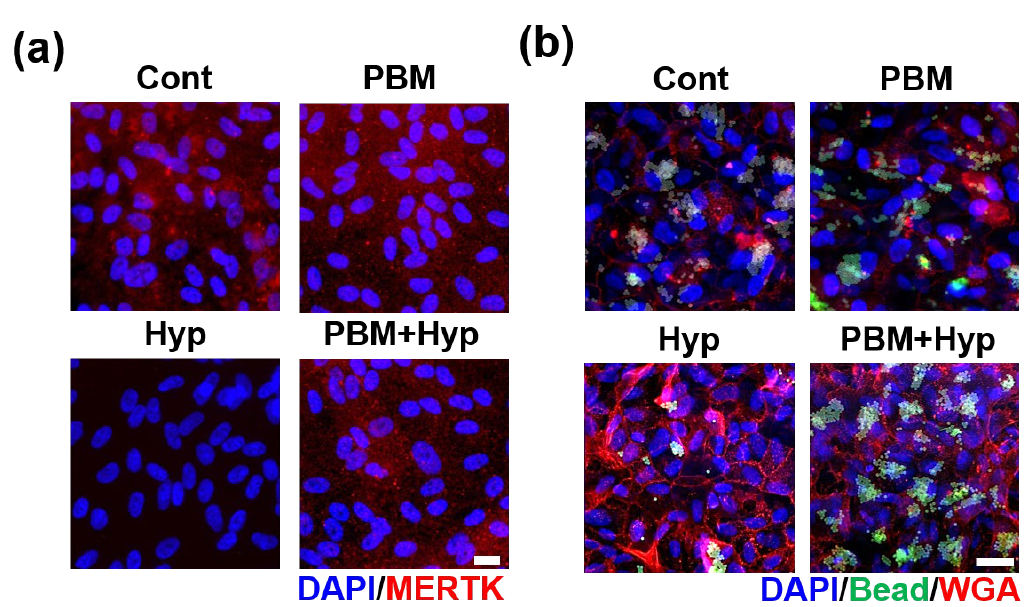
Figure 3. Effect of PBM in clearance function. ( a ) Immunofluorescence image of MERTK. ( b ) Bead digestion ability. Scale: 20 µ m. Cont: control model, PBM: PBM-treated model, Hyp: hypoxia model, PBM+Hyp: hypoxia model with pre-treatment with PBM.